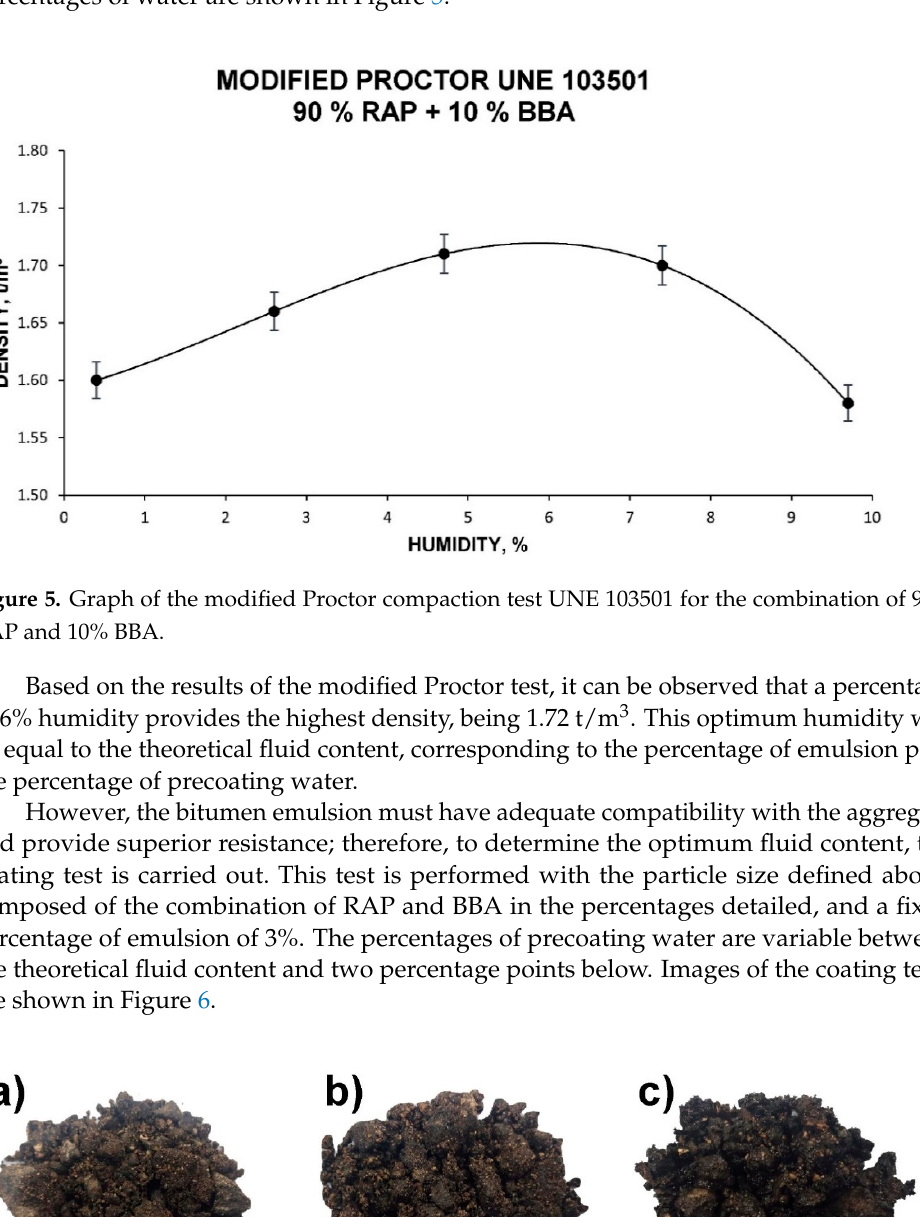
Figure 4. Graph of the grading curve for the combination of 90% RAP and 10% BBA, referenced to the grading envelope of Circular 8/2001 [31].